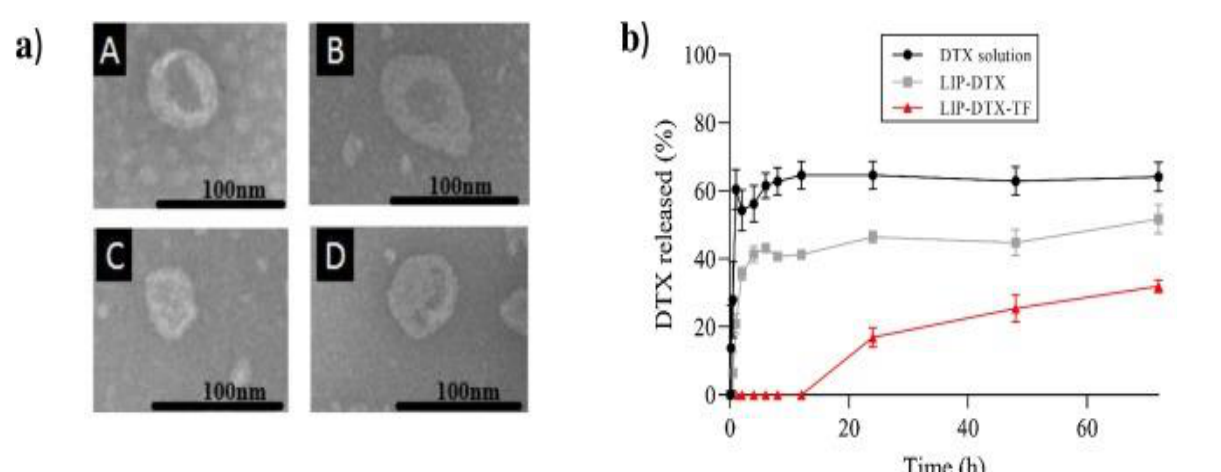
Figure 19. ( a ) Transmission Electron Microscopy of liposomes: ( A ) empty liposomes (LIP); ( B ) docetaxel-loaded liposomes (LIP-DTX); ( C ) empty transferrin functionalized liposomes (LIP-TF); and ( D ) docetaxel-loaded liposomes functionalized with transferrin (LIP-DTX-TF). ( b ) In vitro release profile of free DTX and encapsulated in liposomes in PBS buffer pH 7.4. Adapted from ref. [30], copyright 2021, with permission from Elsevier.